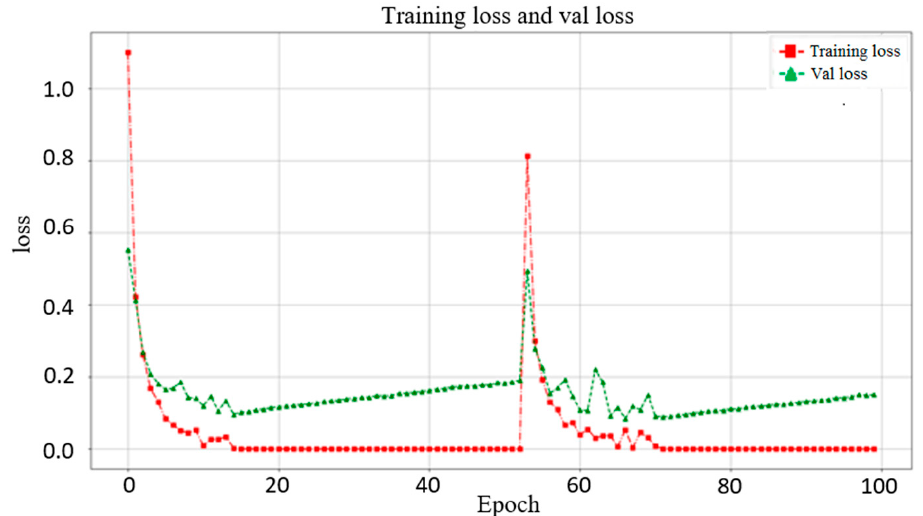
Figure 7. Training loss and validation loss when using VGG16 as the backbone in the single model. The trends of training loss and validation loss for VGG16 show very large fluctuations.